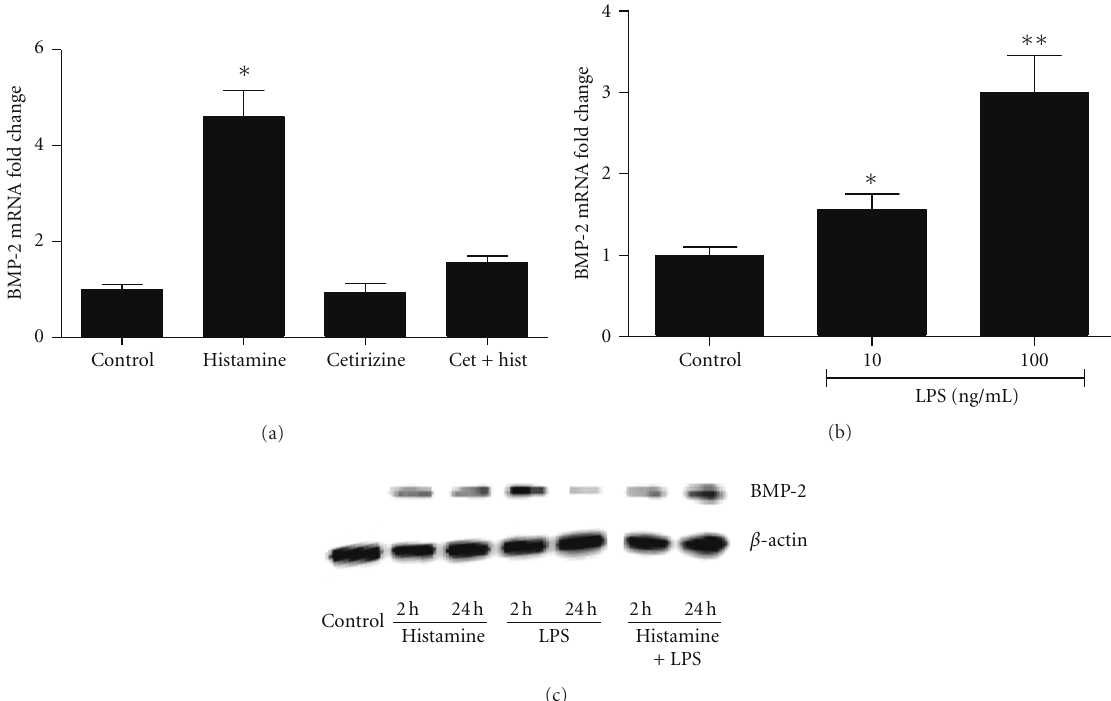
Figure 6: Histamine and LPS induce expression of BMP-2 mRNA. Endothelial cells were incubated with medium (control), histamine, histamine + cetirizine (a), or with 10 or 100 ng/mL LPS (b) for 2 h. Total RNA was extracted, reverse transcribed and, analyzed using specific primer sets for BMP-2 using real-time RT-PCR with β -actin as the housekeeping gene (a and b). Results were analyzed and normalized using β -actin and expressed as fold changes over the control. (c) Endothelial cells were incubated with medium, histamine, LPS, or histamine + LPS for 2 or 24 h, and Western blotting was carried out to determine the expression of BMP-2 protein as described in details in the Section